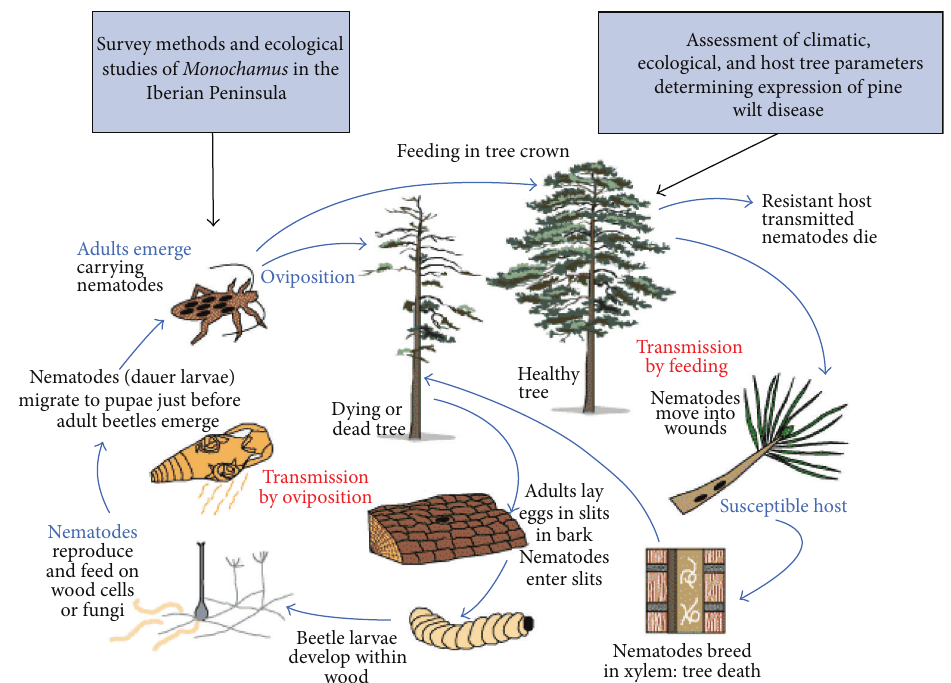
Figure 1: Schematic representation of the interrelationships between the pinewood nematode, Bursaphelenchus xylophilus , and its insect vector ( Monochamus alternatus ) (adapted from Evans et al.